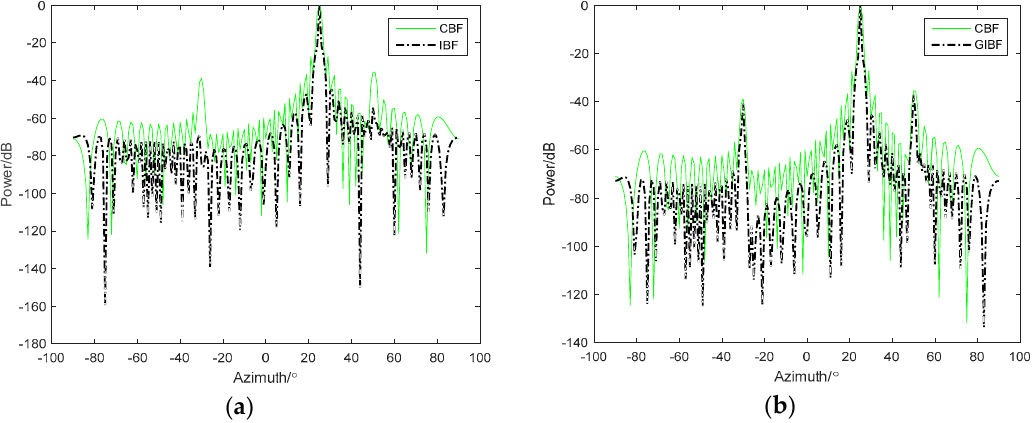
Figure 2. Comparison for three unequal energy targets between ( a ) CBF and IBF and ( b ) CBF and GIBF(the improved inverse beamforming).